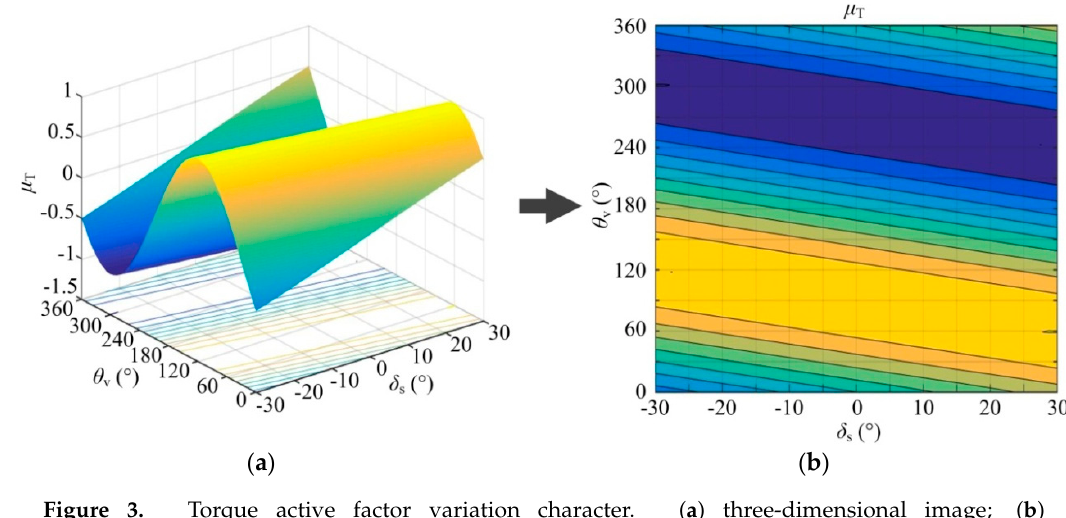
Figure 3. Torque active factor variation character. ( a ) three-dimensional image; ( b ) two-dimensional image.